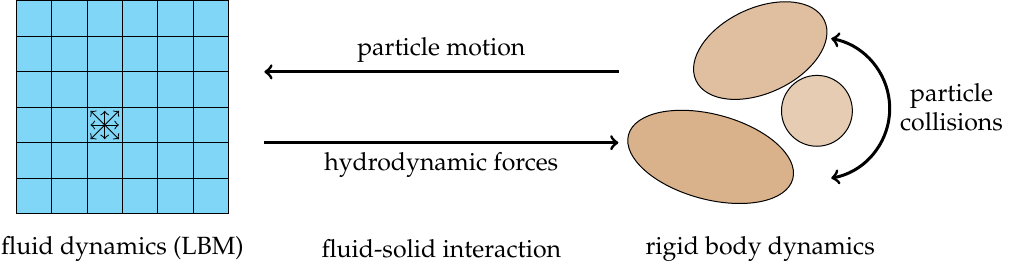
Figure 2. Schematic representation of the numerical methods presented in Section 2 that are used for particulate flow simulations in this